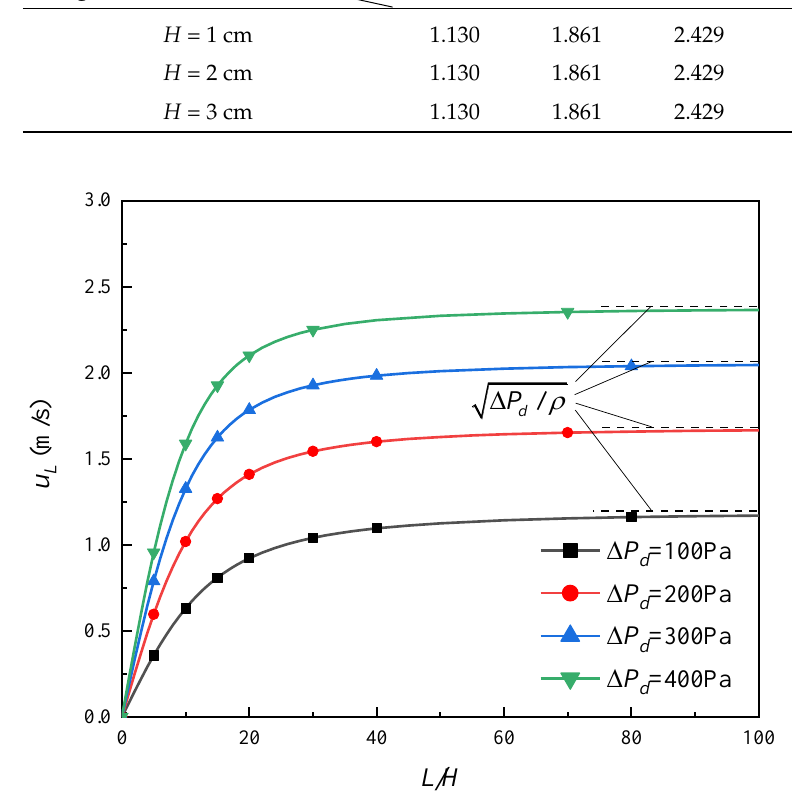
Figure 4. Outflow velocity versus L/H at different driving pressures.